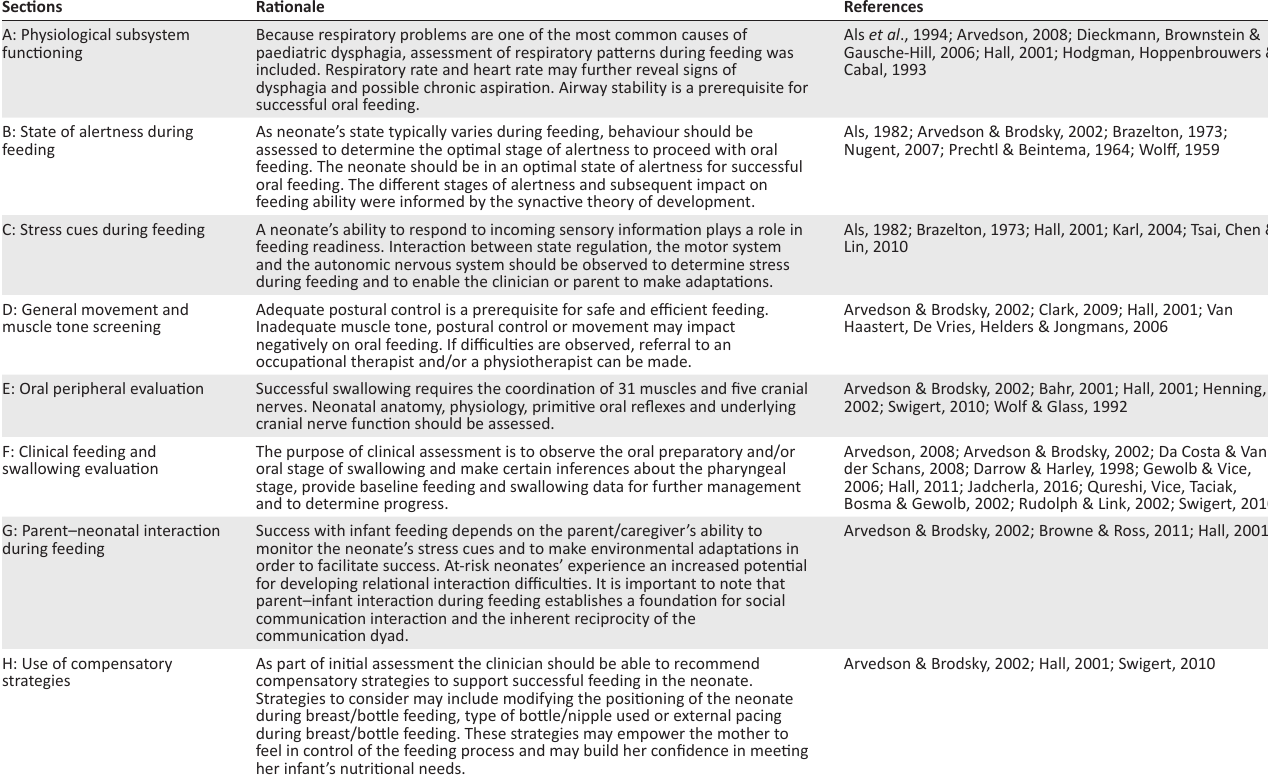
TABLE 4: Preliminary Neonatal Feeding Assessment Scale content and rationale for item selection.